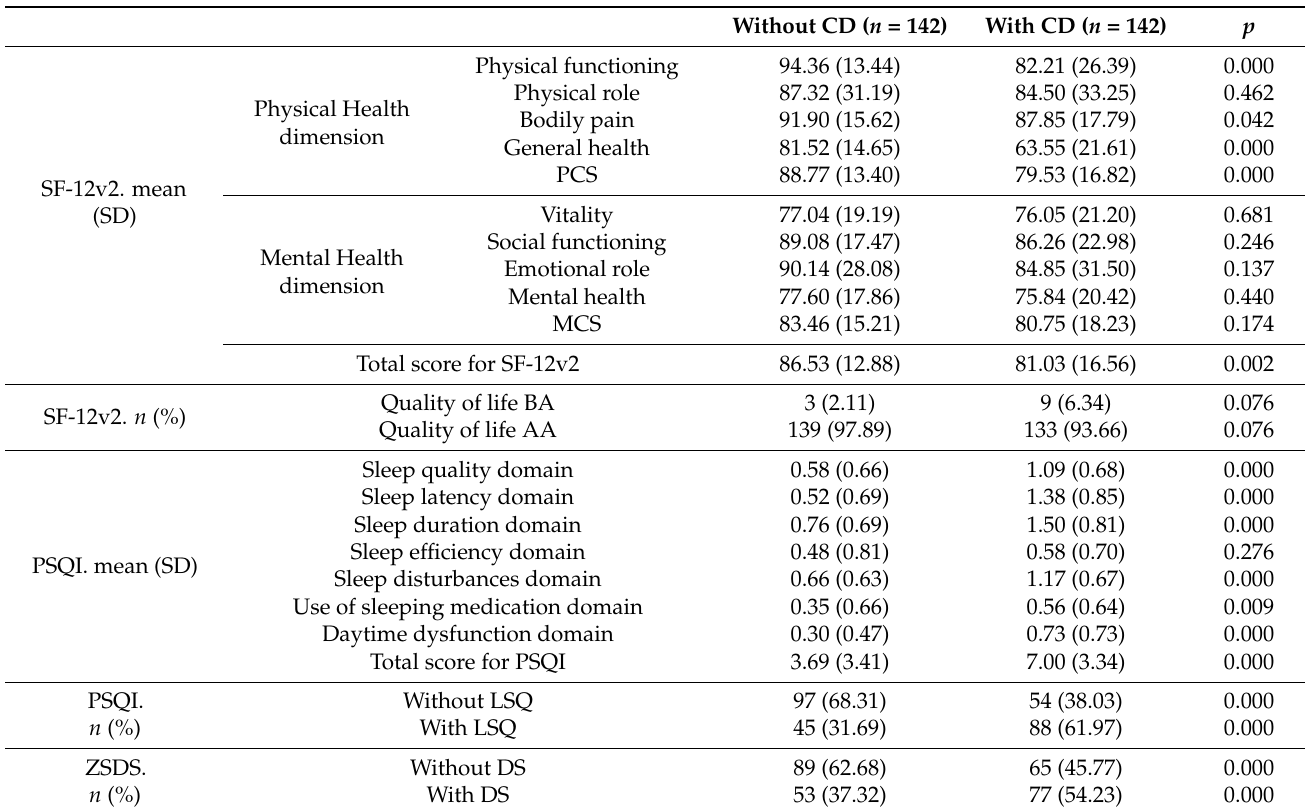
Table 2. Comparison of outcome variables according to cardiometabolic disease classification (without CD and with CD). Without CD ( n = 142) With CD ( n = 142)